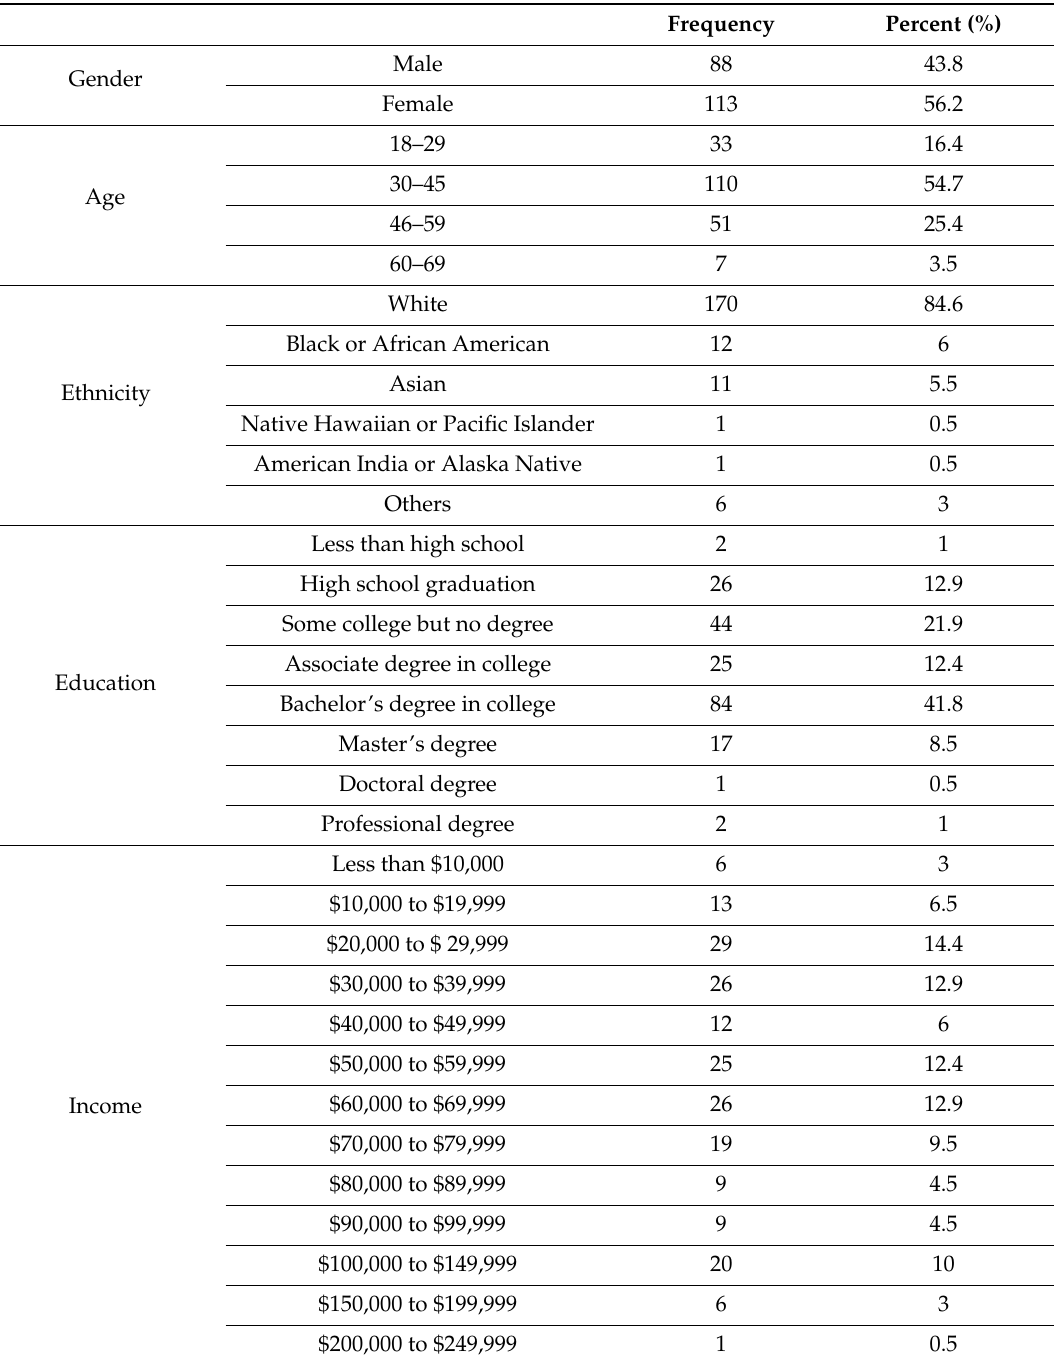
Table A3. Demographic Information